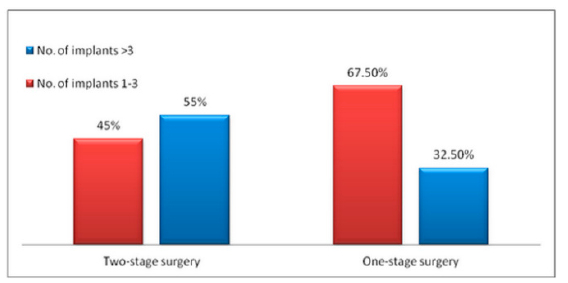
Figure 1. The correlation between the number of implants and the surgical technique.